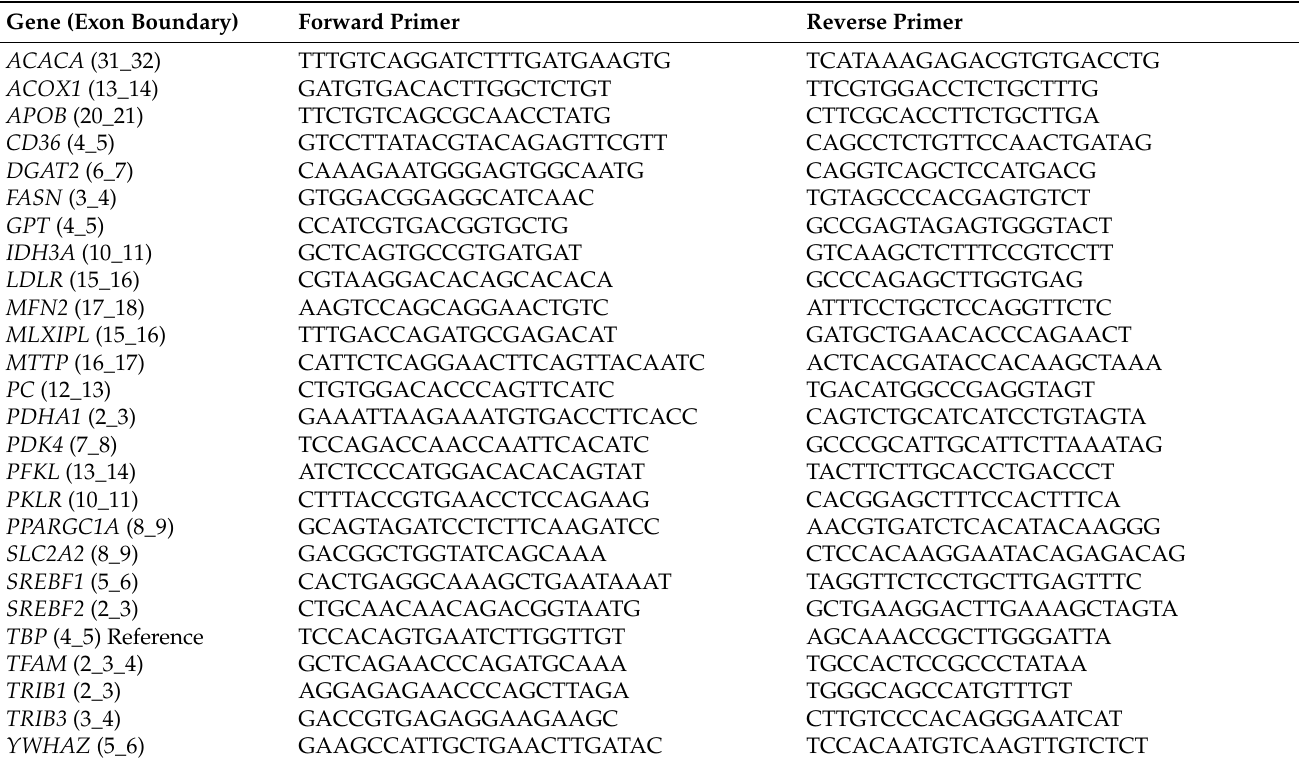
Table 1. Primers designed for real-time